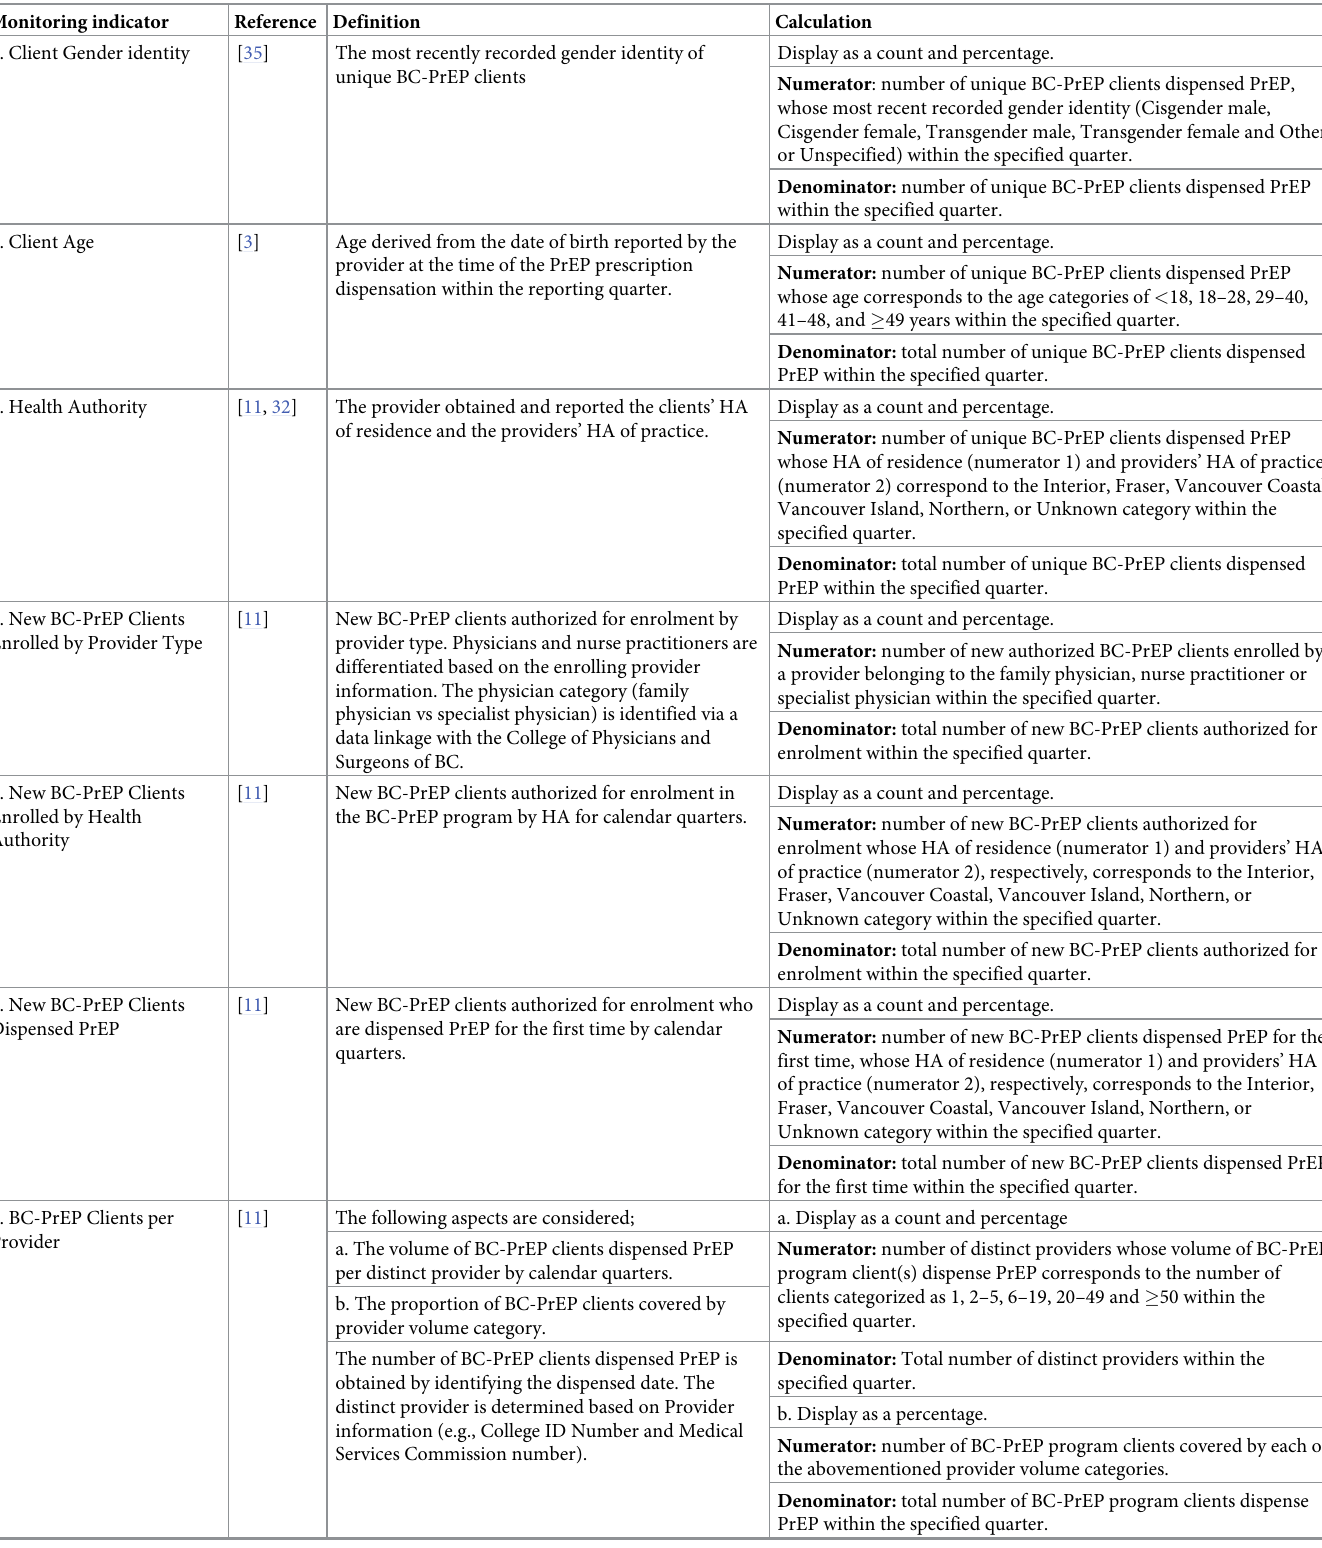
Table 2. Finalized PrEP monitoring indicators, their definitions and their calculation procedure a . Monitoring